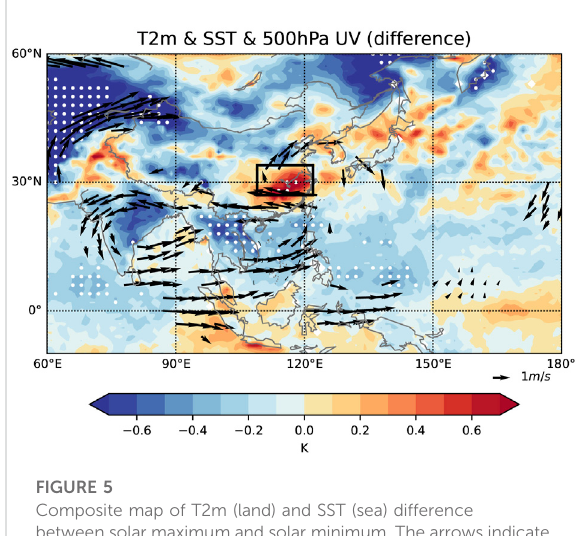
FIGURE 5 Composite map of T2m (land) and SST (sea) difference between solar maximum and solar minimum. The arrows indicate the direction and strength of the 500 hPa wind fi eld. The arrows and dotted regions indicate signi fi cant correlations satisfying the 95% con fi dence level. The range of the MLRYR (rectangle) is consistent with Figure 1A.